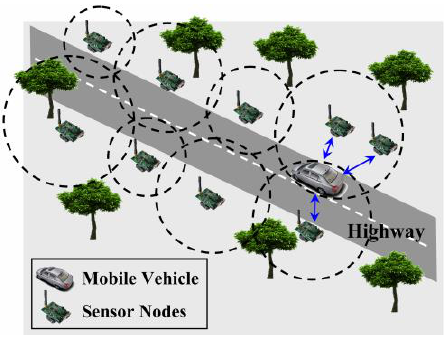
Figure 1. The mobile sink traverses the path to collect data from the one-hop sensor nodes [20].